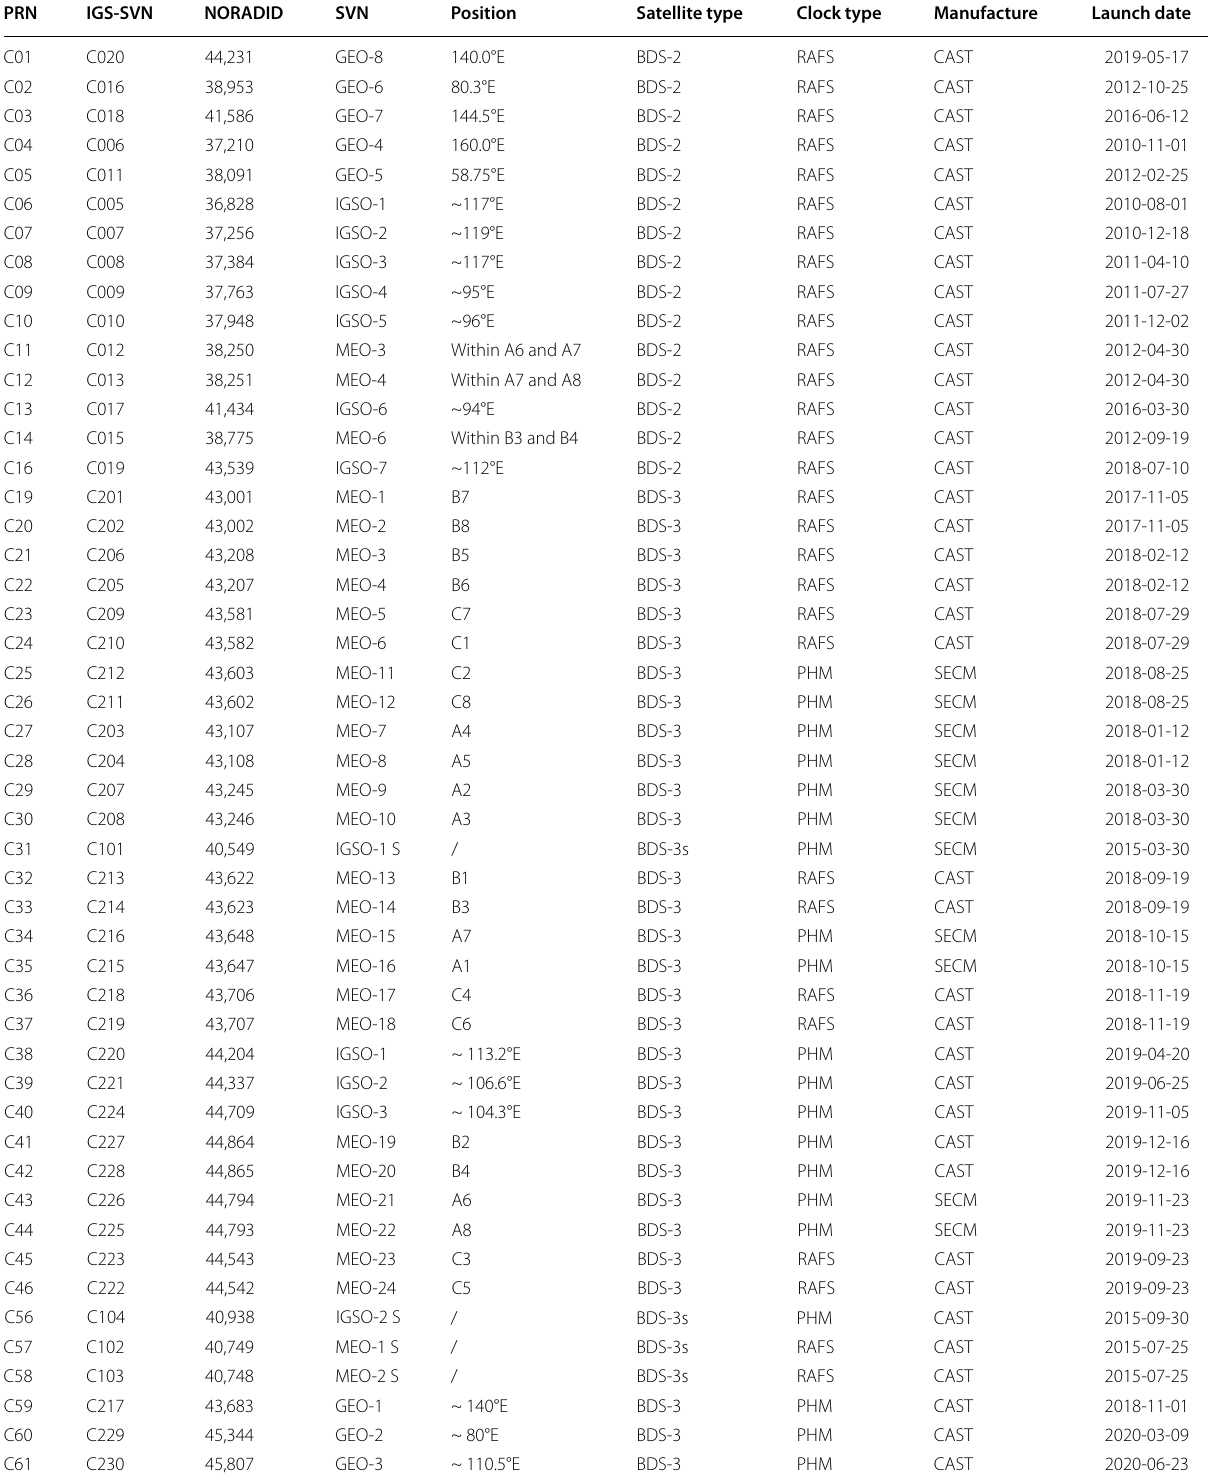
Table 1 The status and information of BDS satellites as 9 September